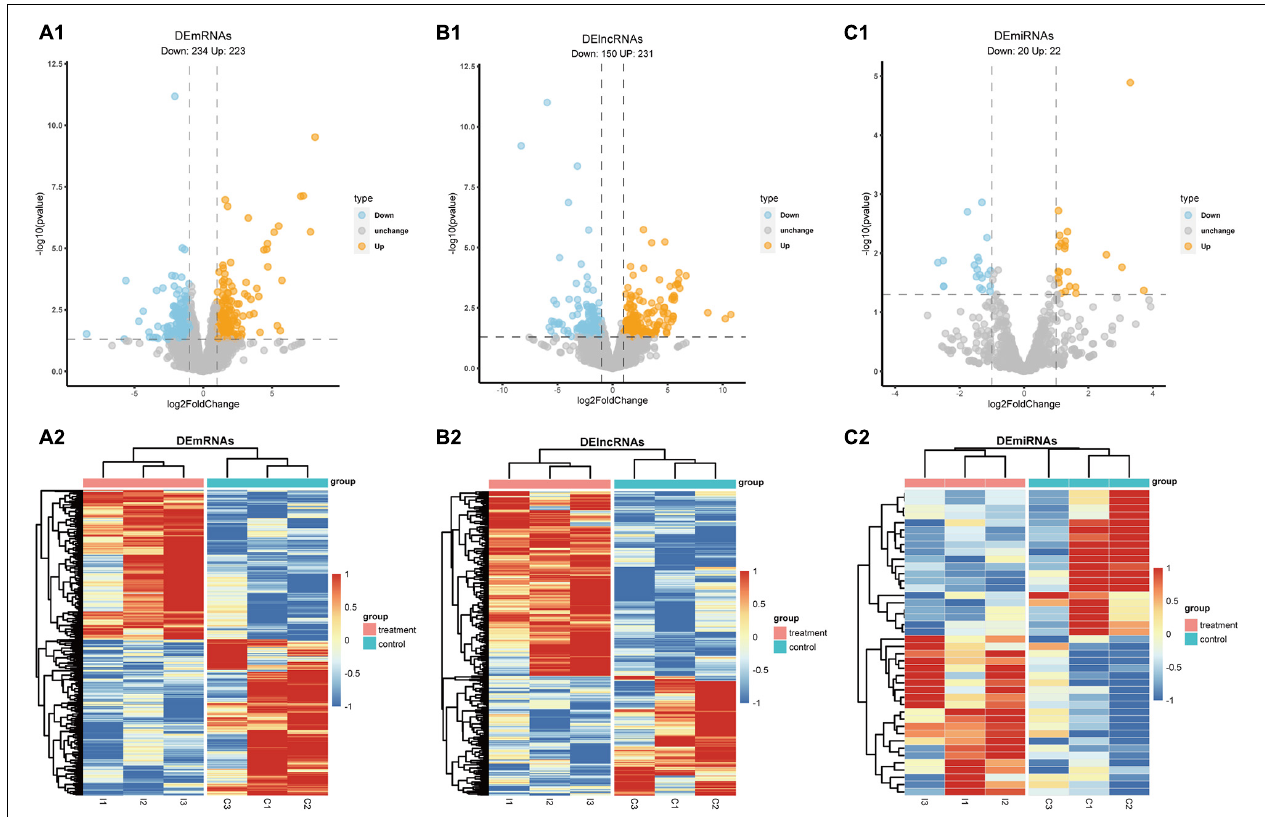
FIGURE 2 | The volcano plot and heatmap of DEmRNAs, DElncRNAs, and DEmiRNAs. (A1,B1,C1) Volcano plot of DEmRNAs, DElncRNAs, and DEmiRNAs; (A2,B2,C2) heatmap of DEmRNAs, DElncRNAs, and DEmiRNAs.